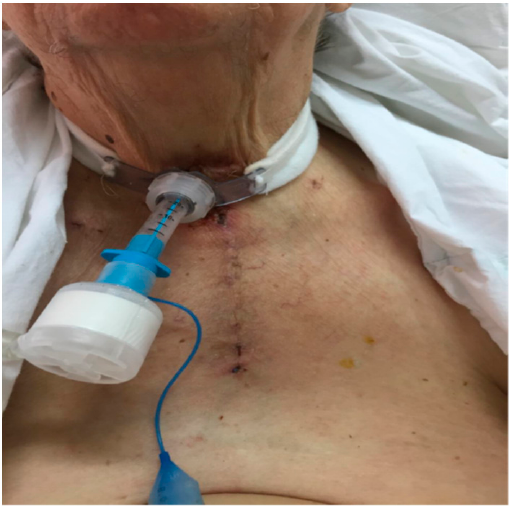
Figure 7. Thirty-eighth postoperative day (POD 38), just before the removal of the tracheostomy